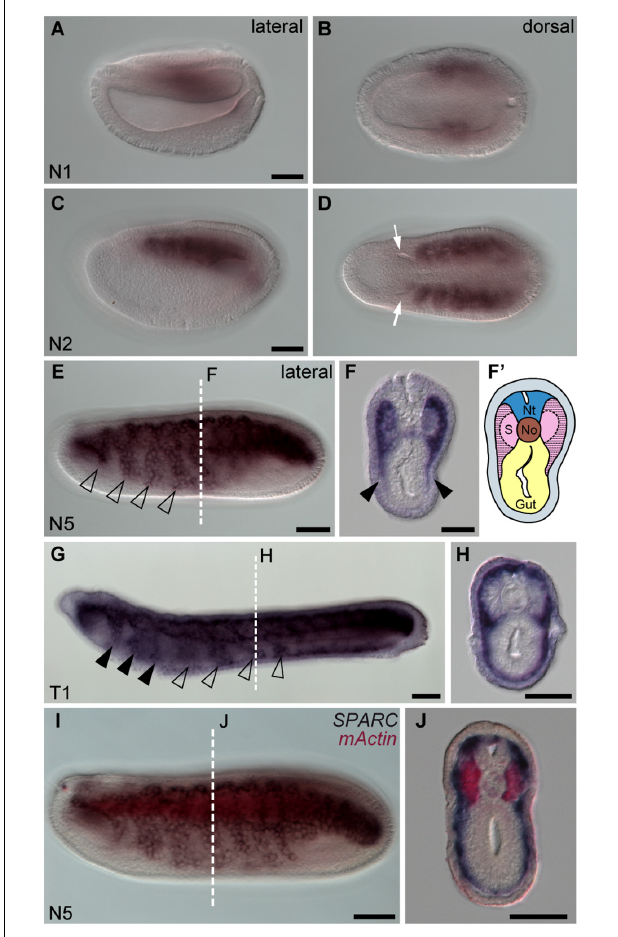
FIGURE 1 | Amphioxus SPARC is expressed in the lateral region (non-myotome part) of the somite. Images (A,C,E,G,I) were taken from the lateral view; the anterior is to the left and dorsal is to the top. Scale bars, 50 µ m. Images (B,D) were taken from the dorsal view, where the anterior is to the left and the right side is on top. Scale bars in (A,C) apply to (B,D) . Cross sections in panels (F , H,J) show the respective level marked with a white dashed line in panels (E , G,I) . Scale bars, 25 µ m. (E) SPARC expressing cells expand ventrally (hollow arrowhead). (F) Black arrowheads indicate the lateral part of the somite that expresses SPARC and extends ventrally. (F (cid:48) ) Schematic drawing of panel (F) ; area filled with dashed lines marks where SPARC is expressed. Nt, neural tube; S, somites; No, notochord. (G) SPARC -expressing cells move to the pharyngeal region (black arrowheads). (I) Double in situ hybridization of SPARC (dark purple) and mActin (red) of a late N5 stage embryo.